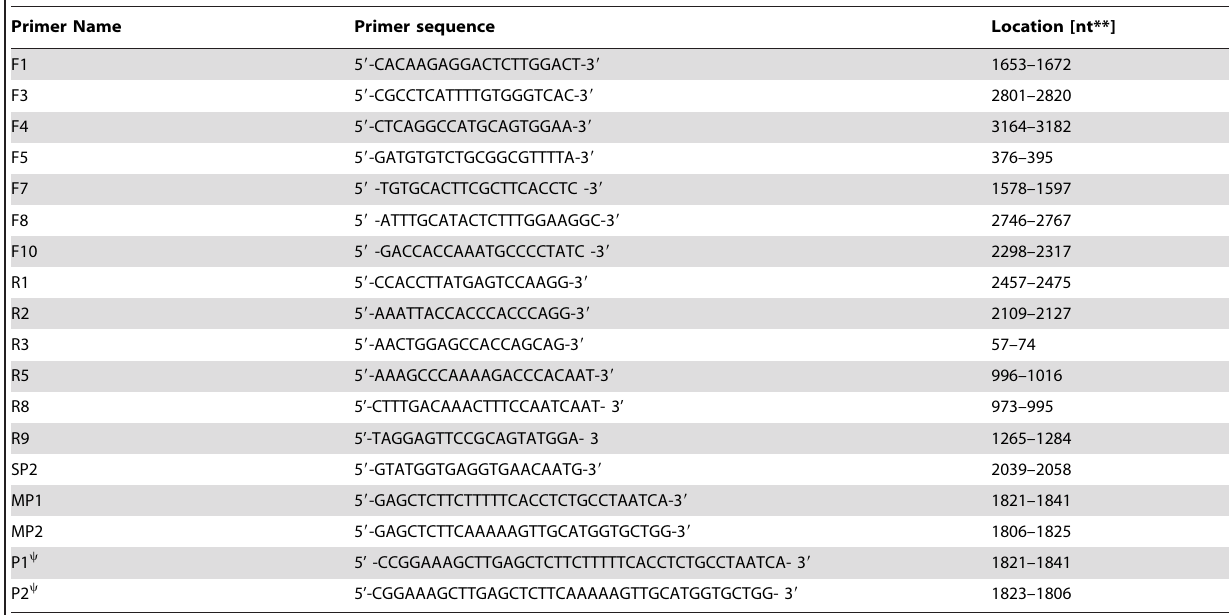
Table 1. Primers used in this